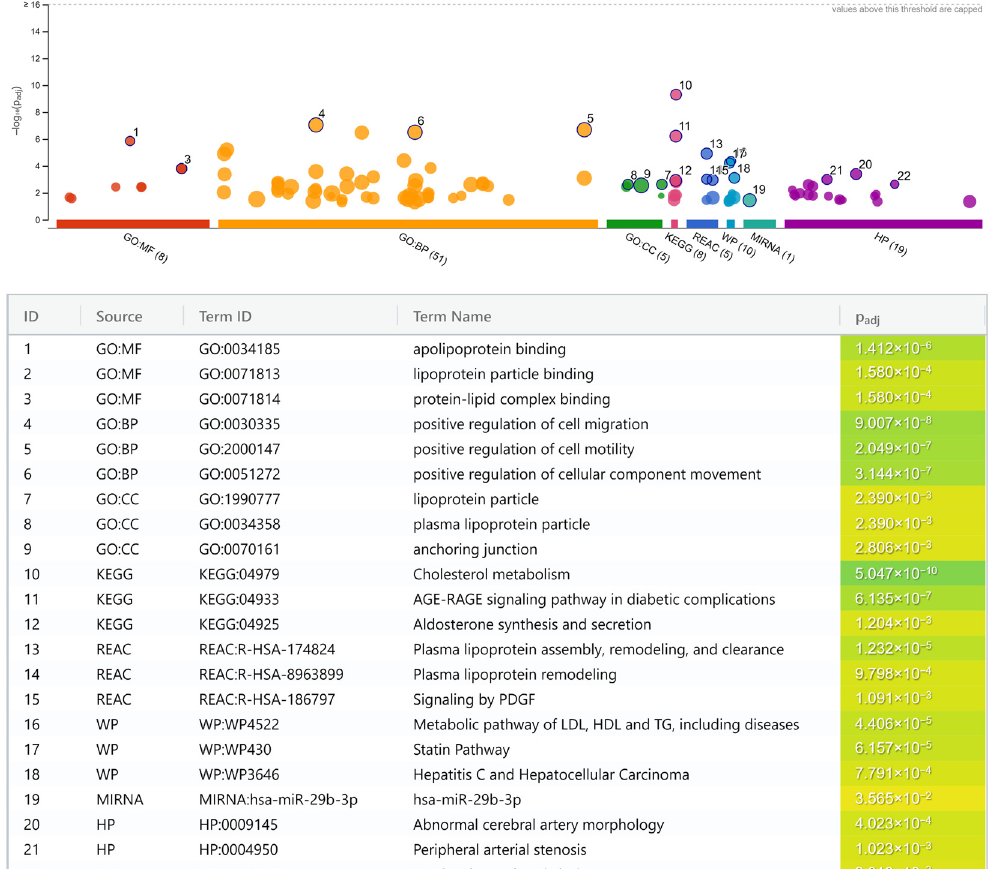
Figure 2. Pathway enrichment analysis using the g:Profiler online tool. The top three significant pathways from each database source were highlighted and labeled numerically. Abbreviations: GO:BP (Gene Ontology:Biological Process); GO:CC (GO:Cellular Component); GO:MF (GO:Molecular Function); HP (Human Phenotype Ontology); KEGG (Kyoto Encyclopedia of Genes and Genome); MIRNA (mirTarBase); REAC (Reactome); WP (WikiPathways).